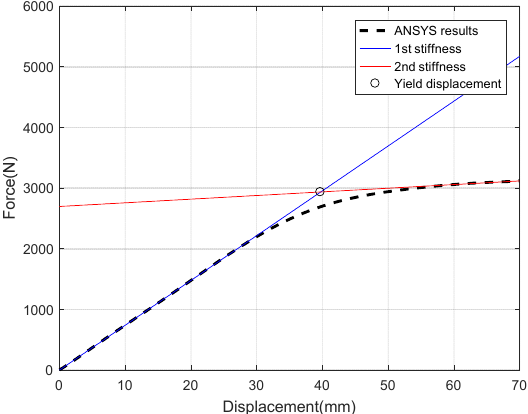
Figure 11. Yield point on the nonlinear response of SCD.